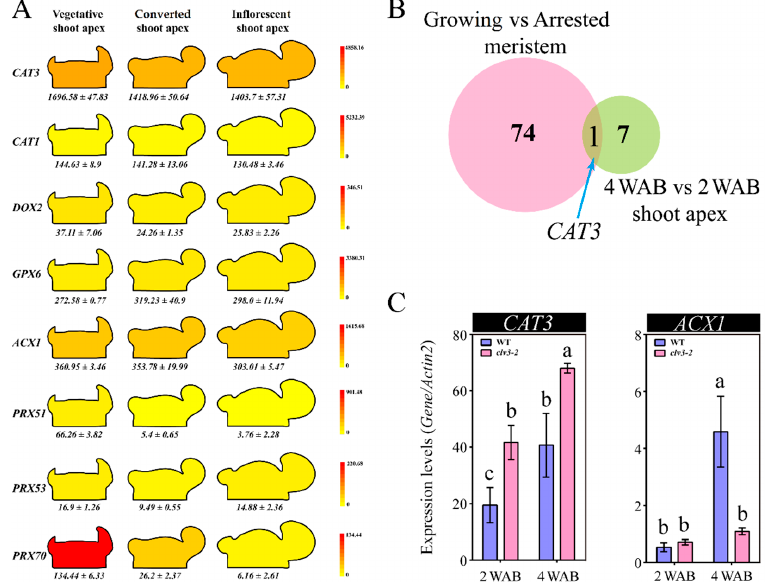
Figure 10. The expression profiles of ROS metabolism-related genes. ( A ) The expression patterns of eight ROS metabolism-related genes in the BAR database. The gene expression data in vegetative, converted (i.e., the transition from the vegetative stage to the proliferative stage), and inflorescent (i.e., proliferative stage) shoot apex are shown. ( B ) Common gene isolation between two published RNA-seq datasets. One is the comparative data using growing and arrested meristems, and the other is the comparative data using 2 WAB and 4 WAB shoot apexes. ( C ) The expression profiles of the ROS clearance-related gene CAT3 and ROS production-related ACX1 at 2 WAB and 4 WAB in WT and clv3-2 IM tissues. qRT–PCR assays were performed. Each experiment was replicated three times, and error bars indicate SD. One-way ANOVA post Tukey’s HSD test ( p < 0.05) was carried out to calculate the differences among different groups. Different letters indicate significant differ- ences, while the same letters indicate no significant differences.